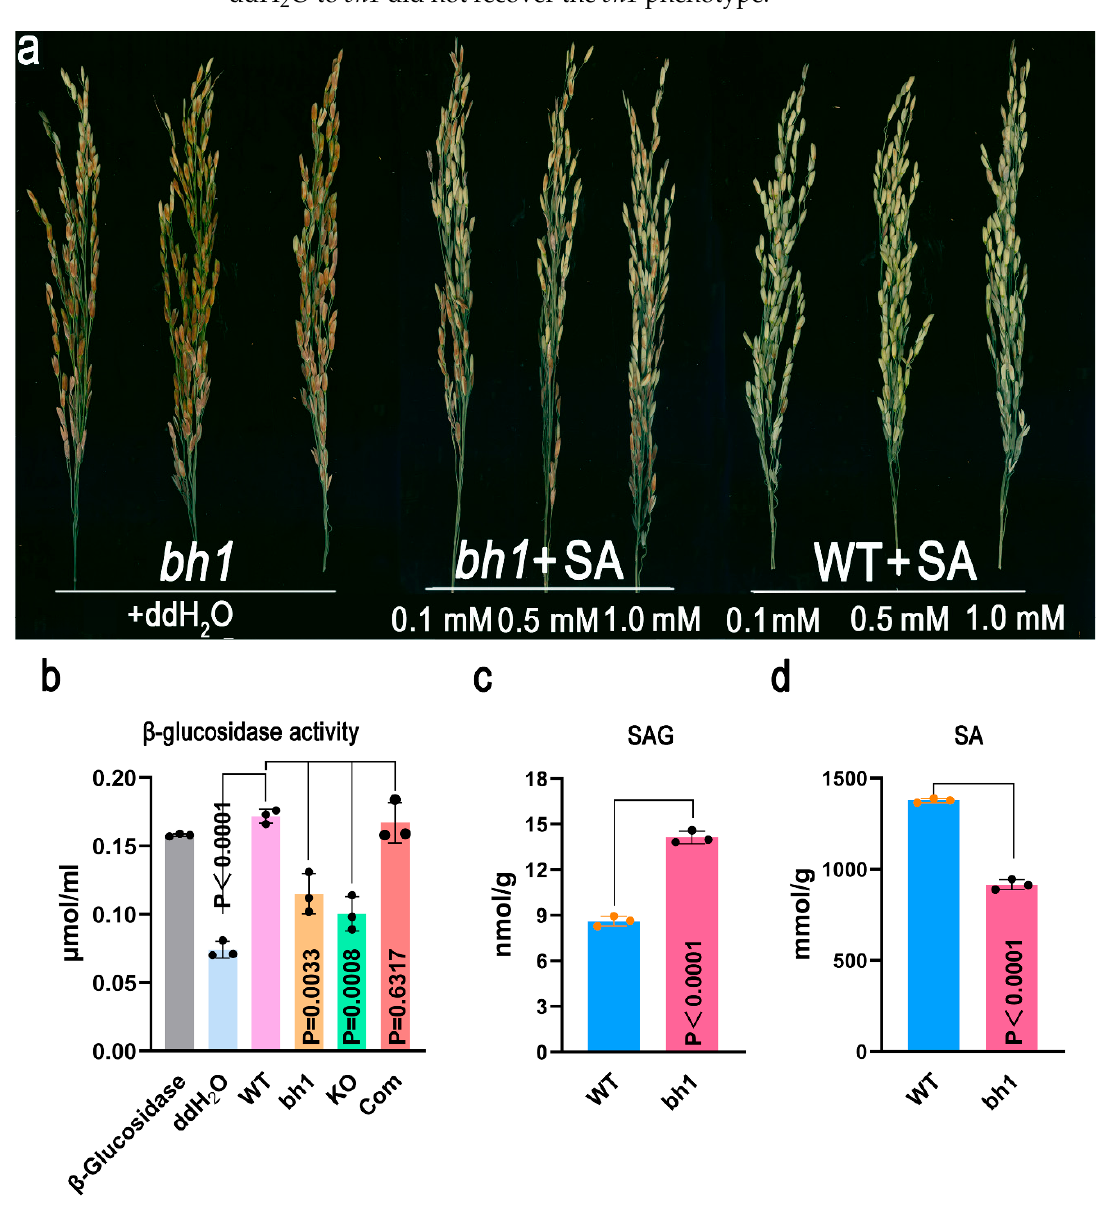
Figure 7. The exogenous application of SA can rescue the (brown hull1) bh1 phenotype and in vivo hydrolysis activity of β -glucosidase (Os1 β Glu4). ( a ) Phenotype of panicles after the exogenous application of SA to bh1 and WT, with ddH 2 O used as a control, ( b ) comparison of β -glucosidase activity in WT, bh1, knockout line and complementation lines, ( c ) The content of SAG, and ( d ) SA in WT and bh1 .